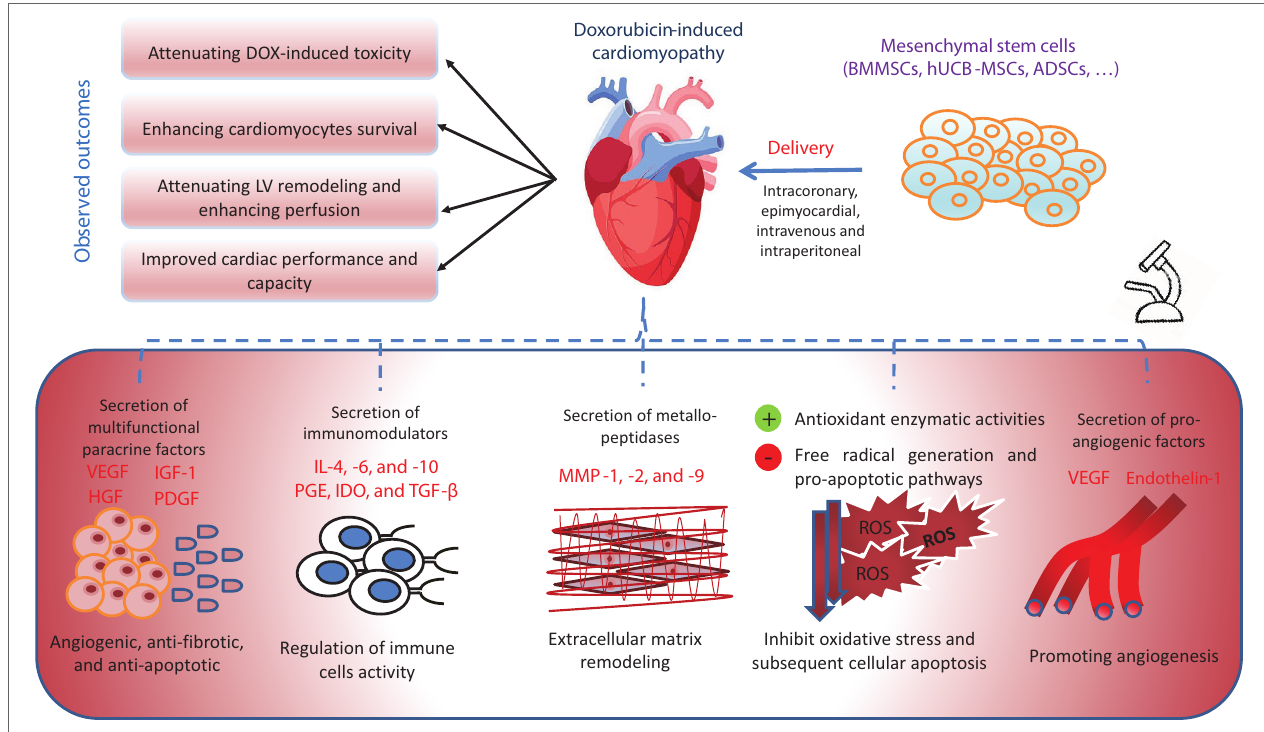
FIGURE 2 | The mechanisms of action of stem-cell-based treatment in ameliorating doxorubicin-induced cardiotoxicity. ADSCs, adipose-derived stem cells; BMMSCs, bone-marrow mesenchymal stem cells; HGF, hepatocyte growth factor; hUCB-MSCs, human umbilical cord blood mesenchymal stem cells; IDO, indoleamine 2,3-dioxygenase; IGF-1, insulin-like growth factor-1; Il, interleukin; MMP, matrix metallopeptidase; PDGF, platelet-derived growth factor; PGE, prostaglandin E; ROS, reactive oxygen species; TGF- β , transforming growth factor- β ; VEGF, vascular endothelial growth